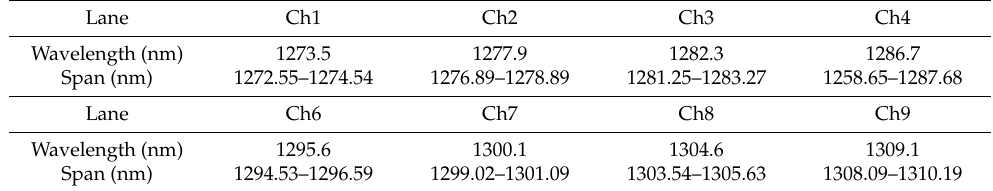
Table 1. The central wavelength and range of eight channels.